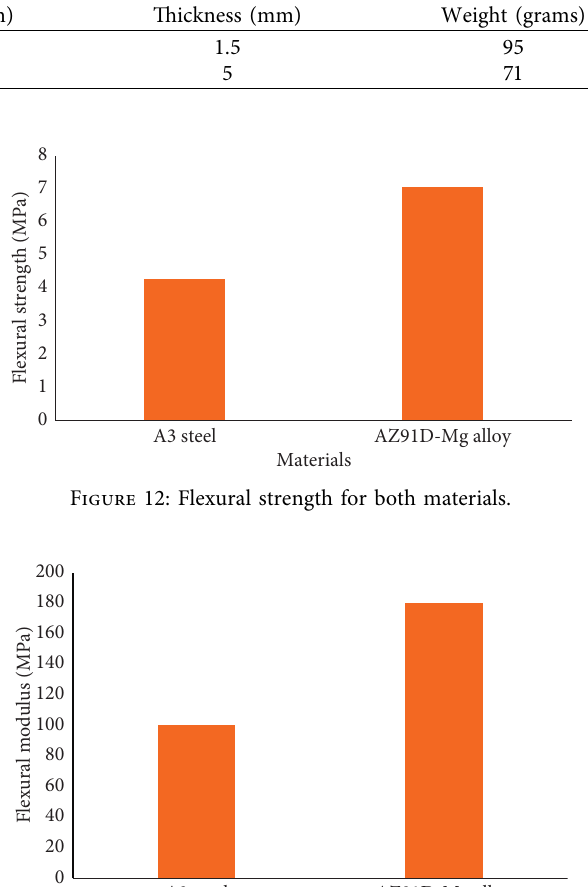
Table 9: Dimensions and Weight of Specimen for sound absorption analysis.